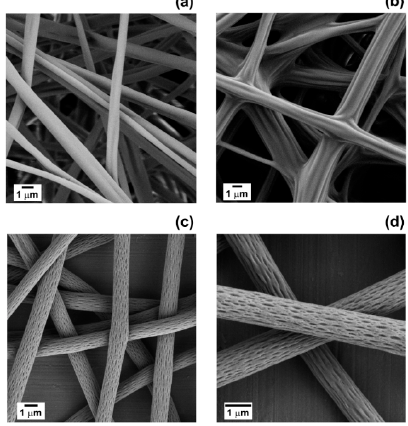
Figure 1. FEGSEM images of electrospun fibres of ( a ) PLA; ( b ) PLA/CS-EO (10% v / v CS-EO) and ( c , d ) PLA/BP-EO (10% v / v BP-EO) at different magnifications.